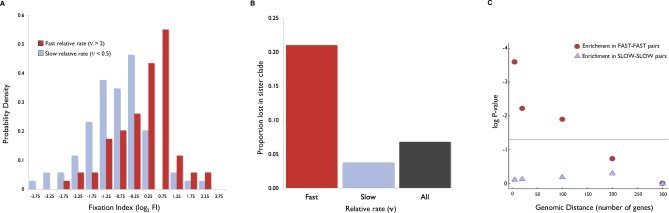
Evidence for Positive and Negative Natural Selection(A) Comparison of relative rates (ν) and Fixation Index. Histograms show the frequency (probability density) distribution of FI values for fast-evolving (ν > 2; dark red; n = 69) and slow-evolving (ν < 0.5; light blue; n = 63) genes. Bins are labelled with the FI value corresponding to their midpoint, on a log2 scale. FI was calculated by counting fixed and polymorphic substitutions at synonymous and nonsynonymous sites, in a sample of 473 COGs (all present in the relatives rates dataset, and consistent with the species tree topology according to the K-H test, as described in the Methods) in 24 E. coli strains, using S. enterica as an outgroup.(B) Purifying selection and gene deletions. Fast-evolvers (or slow-evolvers) were defined as those genes evolving four times faster (or slower) than expected (ν > 4.0 or ν < 0.25, respectively, for fast and slow, with a Z-score > 1.0). For the fast and slow sets of genes, we counted the number with lost orthologs in the closest sister clade in the species tree. When the sister clade contains multiple species, loss indicates the gene was absent from all species in the clade. Frequency of loss among the fast and slow sets was significantly different than the average over all other genes: higher in the fast-evolving set (Fisher's exact test: Odds Ratio = 3.1, p = 2.4e-7), and lower in the slow-evolving set (Fisher's exact test: Odds Ratio = 0.55, p = 0.01).(C) Evidence for genetic hitchhiking. A binomial test was used to determine whether fast (or slow) evolving genes tend to be clustered in the genome near other fast (or slow) evolving genes across all 30 species combined (ν > 1 or ν < 1, respectively, for fast and slow, with a Z-score > 1.0). Log p-values are plotted for pairs separated by distance-windows of 0–5 genes, 6–20 genes, 21–100 genes, 101–200 genes, and 201–300 genes (points shown indicate the maximum separation). The gray line represents p = 0.05.